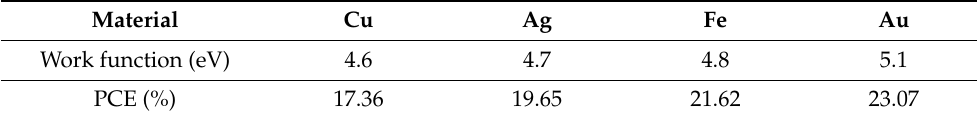
Table 2. Work function of various back contact materials for PSC.